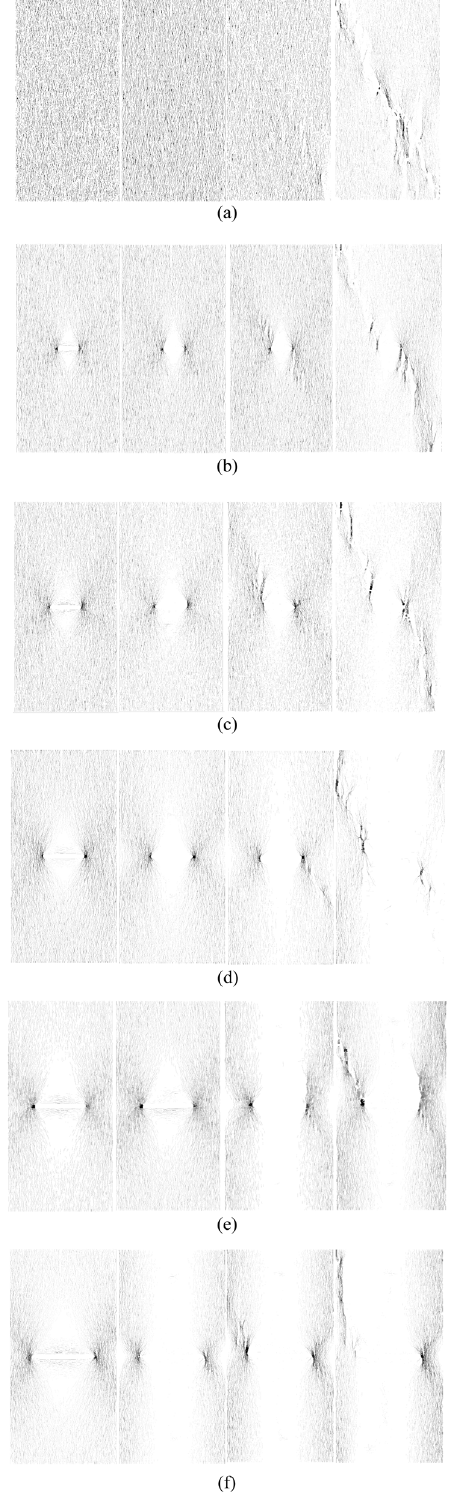
Figure 7: The force chains change of six models: ( a ) intact model, ( b ) a : b = 5, ( c ) a : b = 7.5, ( d ) a : b = 10, ( e ) a : b = 12.5, and ( f ) a : b = 15.